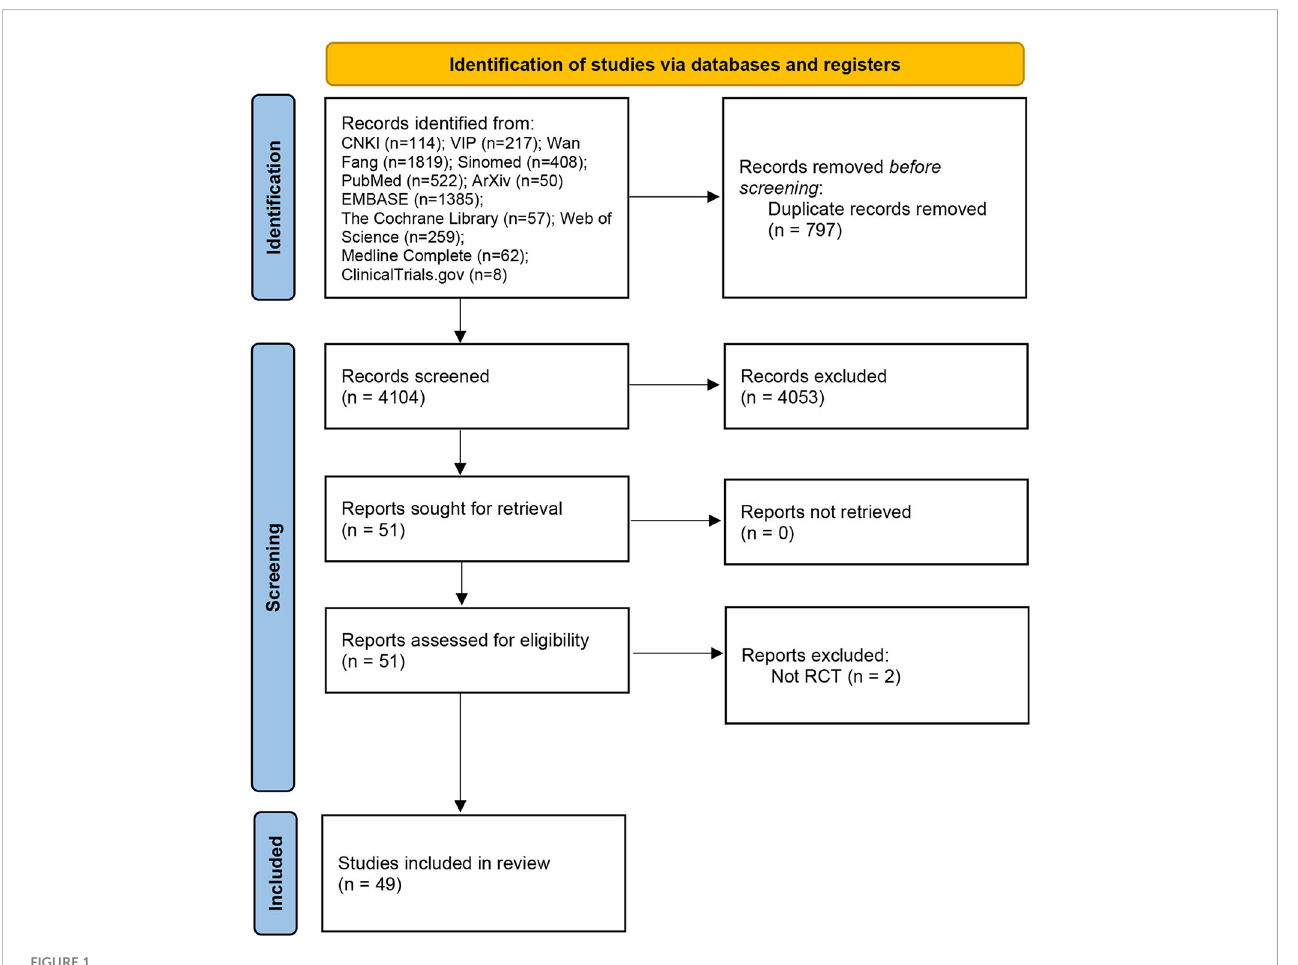
FIGURE 1 Flow diagram of clinical